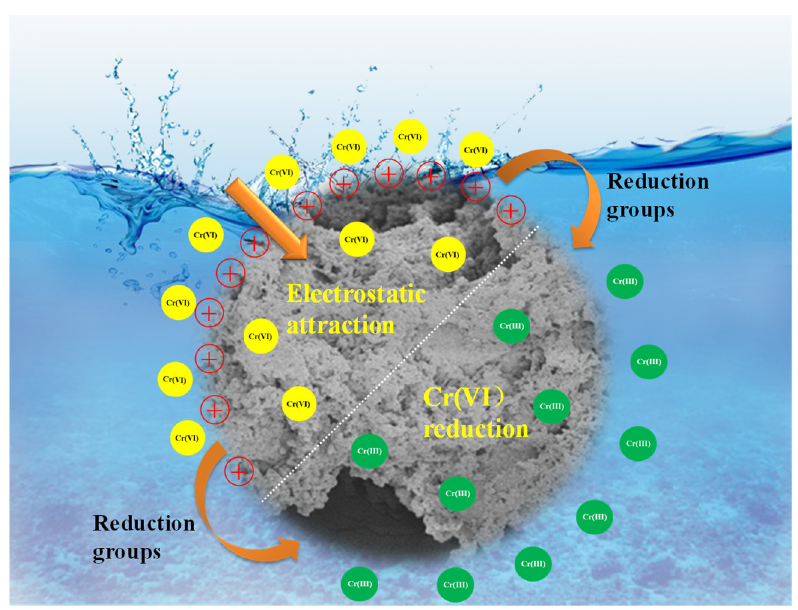
Figure 10. Proposed adsorption mechanism of Cr (VI) by DAPFP.